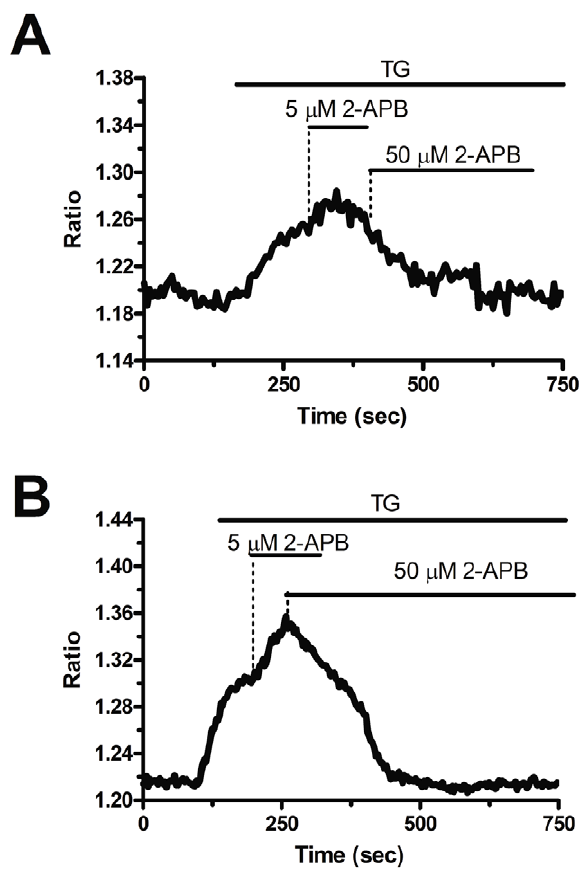
Figure 8. The bi-phasic effect exerted by 2-APB on store- operated Ca 2 + entry in endothelial colony forming cells. 5 m M 2- APB enhances SOCE induced by thapsigargin (TG), whereas 50 m M inhibits it, in both N-EPCs (A) and RCC-EPCs (B). The traces are representative of, respectively, 51 and 57 cells from at least three independent donors. Thapsigargin was administrated at 2 m